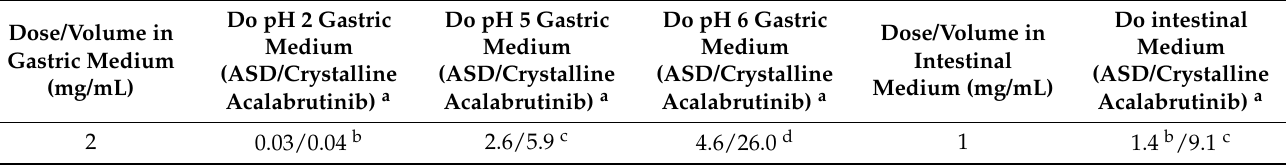
Mass Concentration Molar Concentration (mM) (g/L)